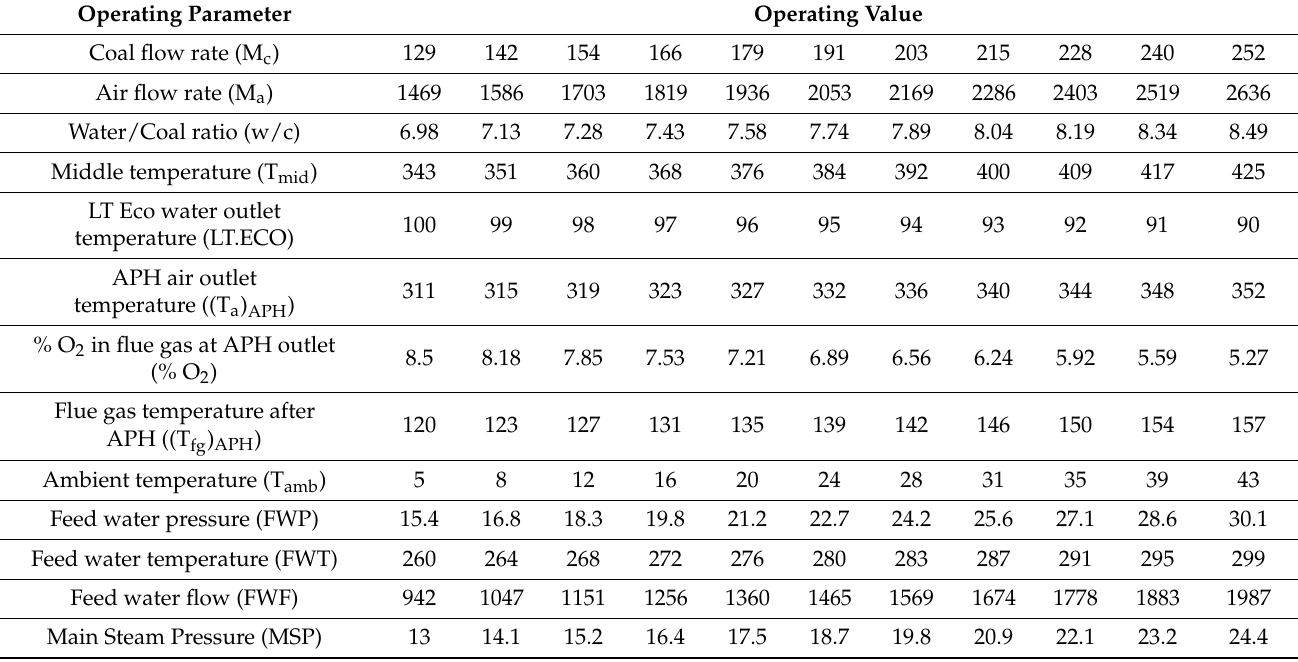
Table 4. Operating values for generating the performance curve of generator